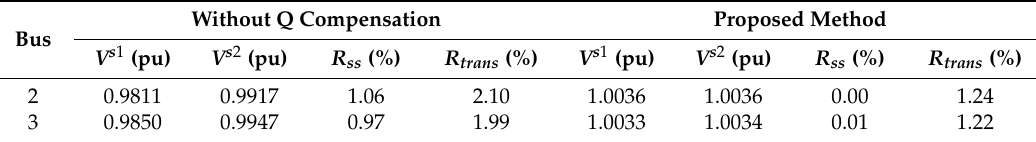
Figure 5. Voltage responses with the proposed method in Case 1. ( a ) Bus 2 ( b ) Bus 3. Table 4. Comparison of voltage variations in Case 1. Table 4. Comparison of voltage variations in Case 1.